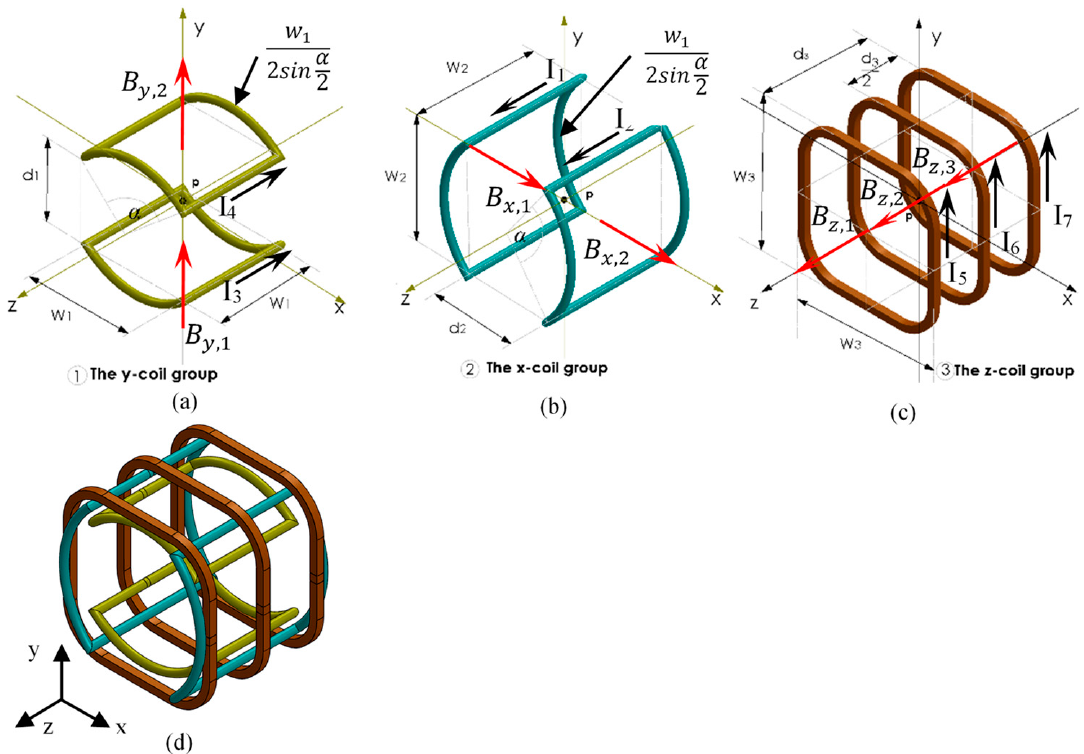
Figure 4. The models Of the Hybrid system with parameters. ( a ) The configuration of three coil groups. ( b ) The y-coil group. ( c ) The x-coil group. ( d ) the z-coil group. Bending angle is 45°, so α = 90°.